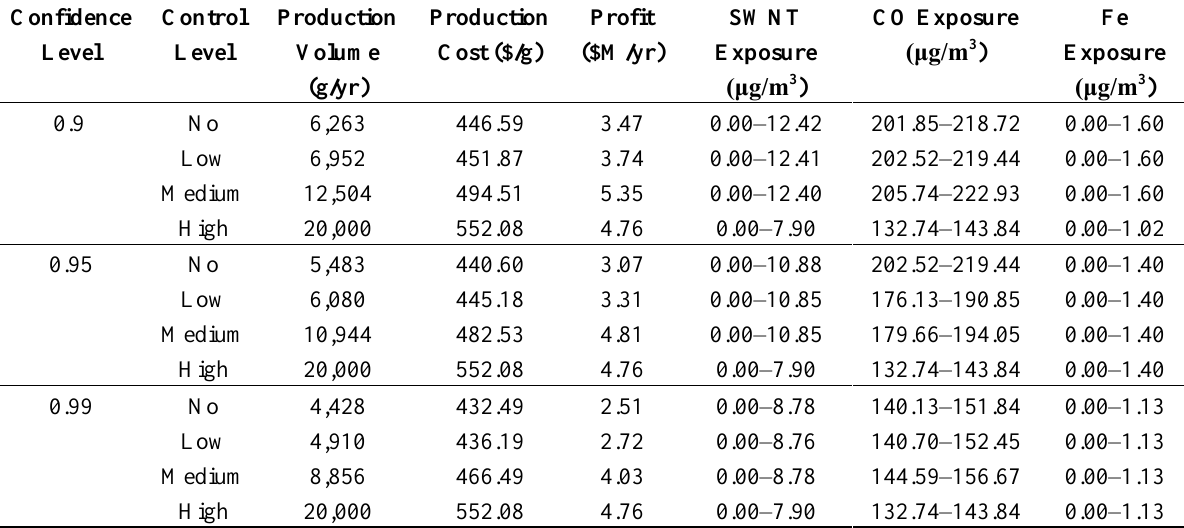
Table 6. Results of the CCNLP